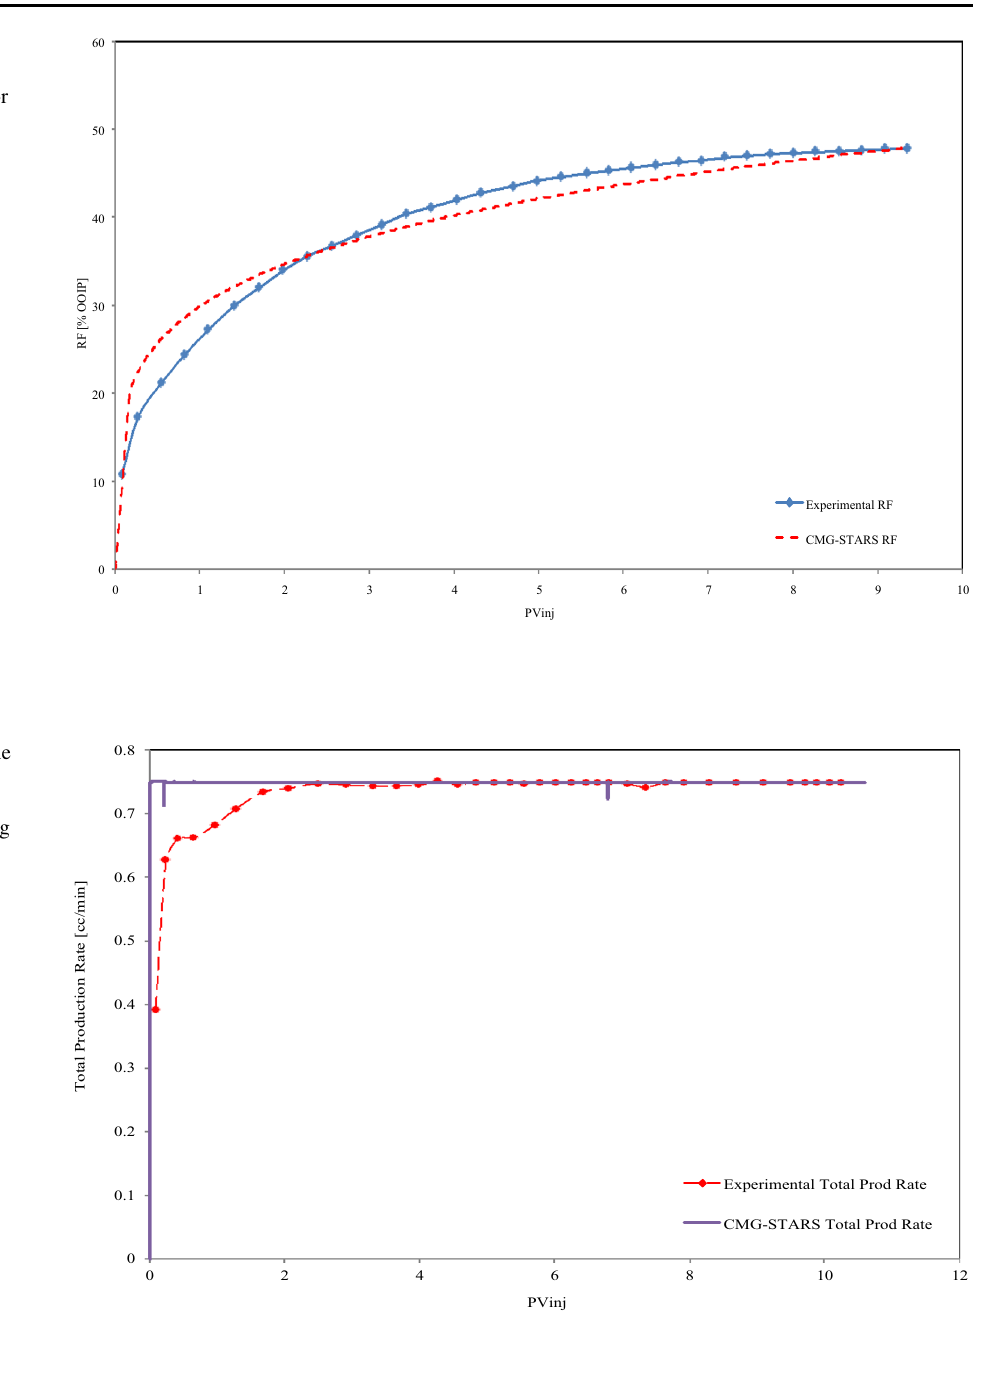
the total production rate curves, water cut and oil curves, and pressure drop curve were successfully matched, which ended with good history matching for the cumulative oil production curves, as can be depicted from Fig. 14.